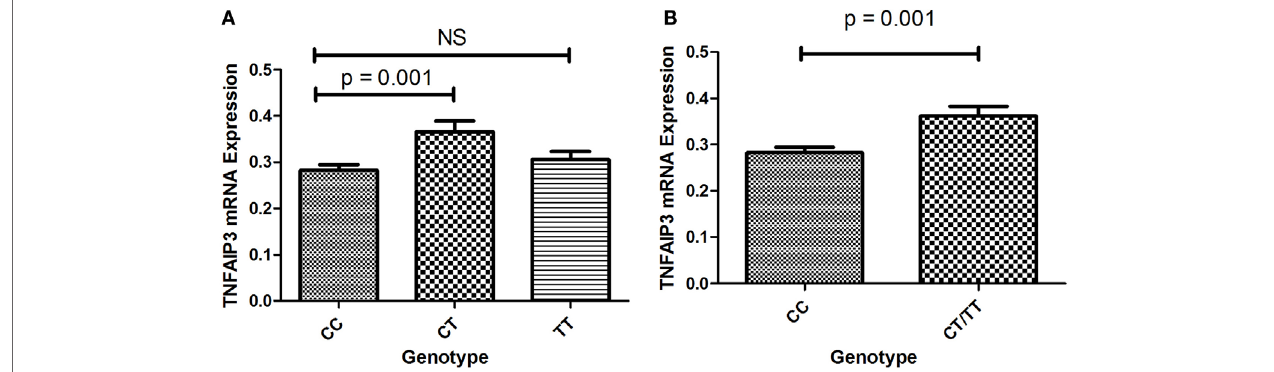
FigUre 1 | (a) Expression of TNFAIP3 mRNA in ITP patients with the CC, CT and TT genotypes. (B) Expression of TNFAIP3 mRNA in ITP patients with the CC and pooled CT/TT genotypes.